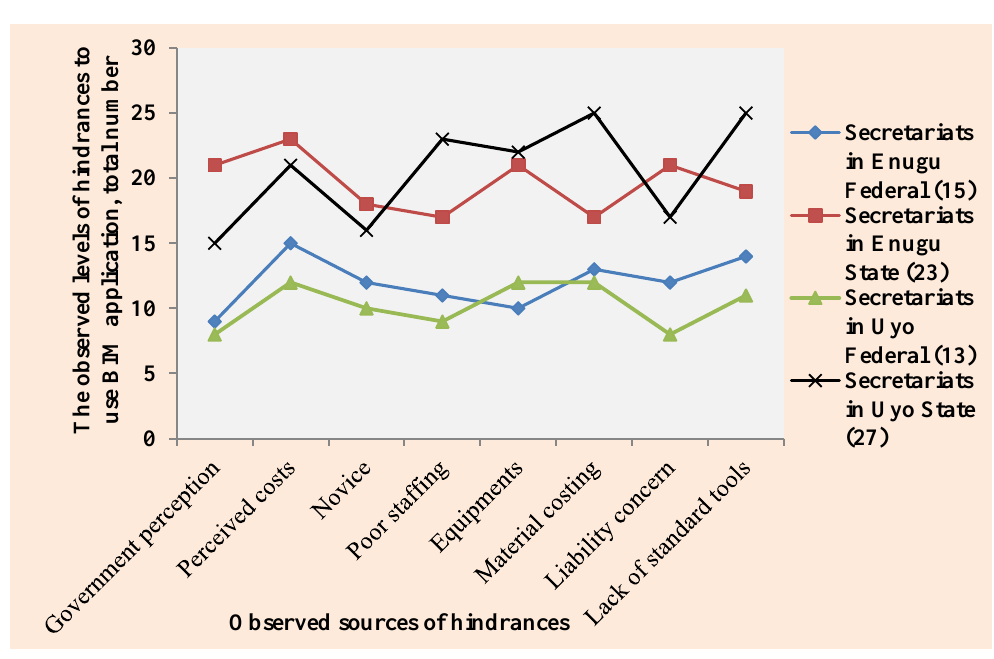
Fig. 9. Hindrances to the use of BIM for the management of PBs (developed by the authors).